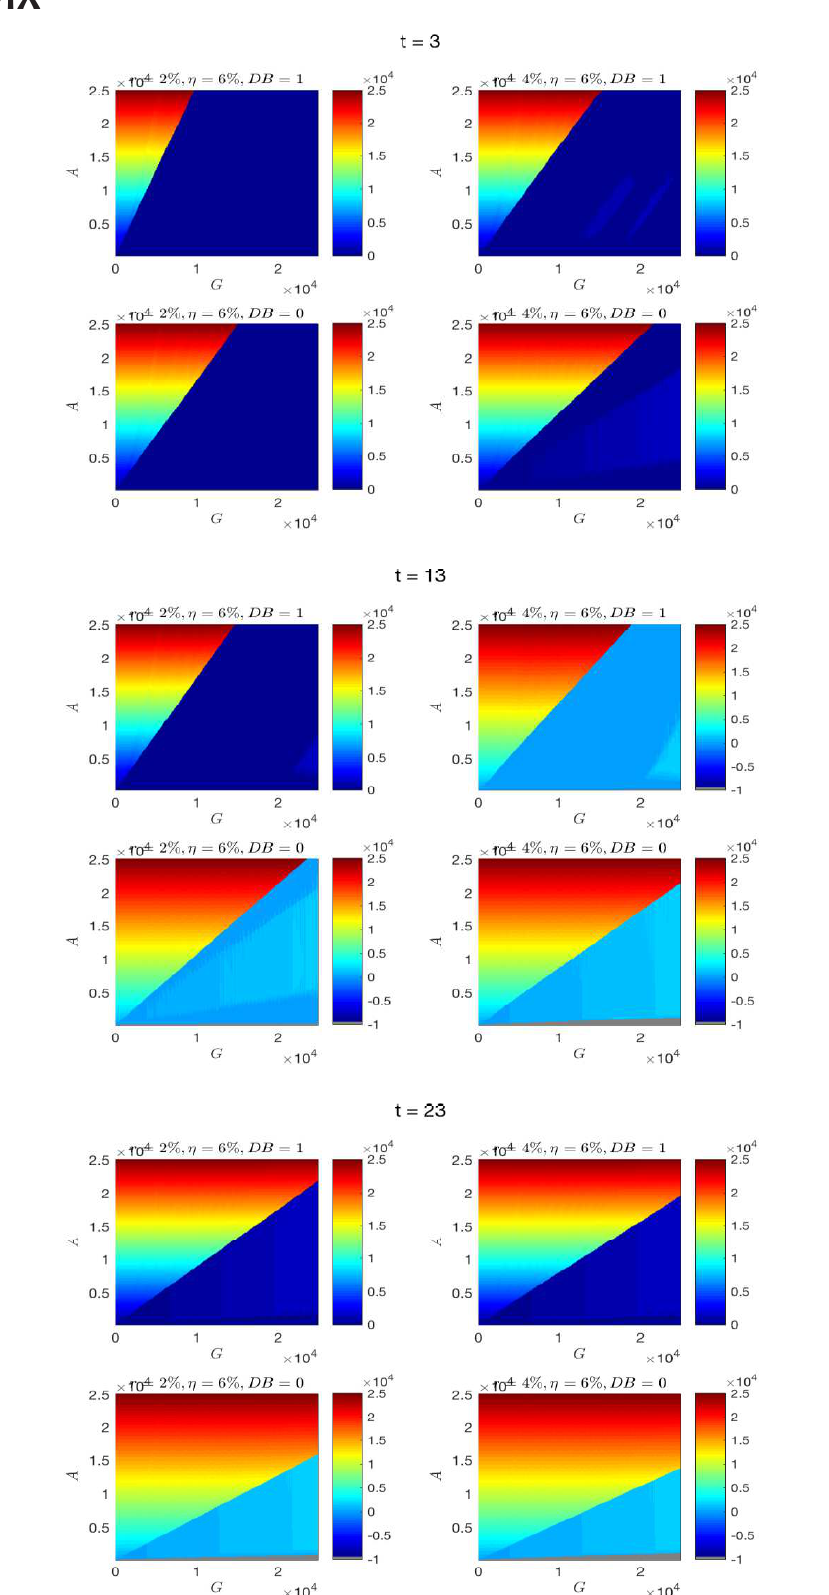
Figure A1. Policyholder optimal withdrawals amount as a function of the account value A and benefit base G for Product A and